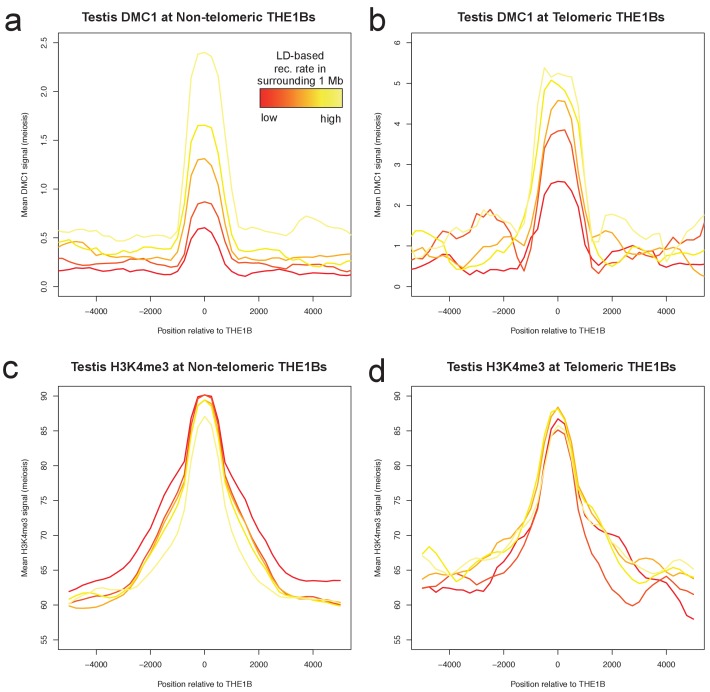
Large-scale recombination rate affects testis DMC1 but not H3K4me3.Profiles of mean DMC1 and H3K4me3 read coverage from human male testes (with a PRDM9 A/B genotype; Pratto et al., 2014) around all THE1B repeats, stratified into quantiles based on the pedigree-based recombination heat in the surrounding 1 Mb of DNA (Kong et al., 2002, excluding the surrounding 20 kb and the repeat itself, by color (red to yellow are increasing 20% quantiles). H3K4me3 shows no impact whatsoever from surrounding recombination rate, implying PRDM9 binding is completely unaffected (c,d). However DMC1 signal increases dramatically (a,b), implying that broad-scale recombination control at these repeats occurs completely independently of PRDM9 binding or local sequence. Note the y-axes are different for telomere and non-telomere DMC1 (a,b) but not H3K4me3 (c,d). Telomeric sites were defined as those occurring within 10 Mb of a telomere, and H3K4me3 values were capped at 500 to reduce outlier effects. .